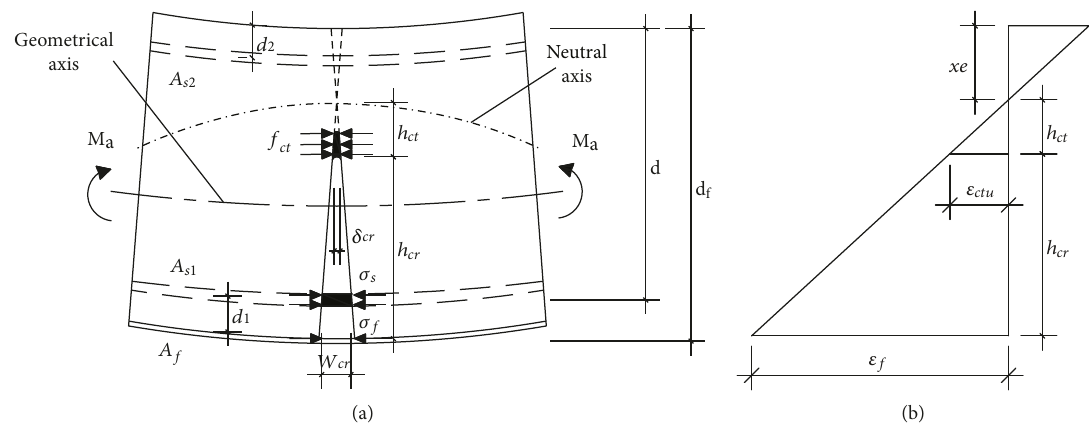
Figure 1: The model for calculation of normal crack propagation: (a) crack model; (b) strain